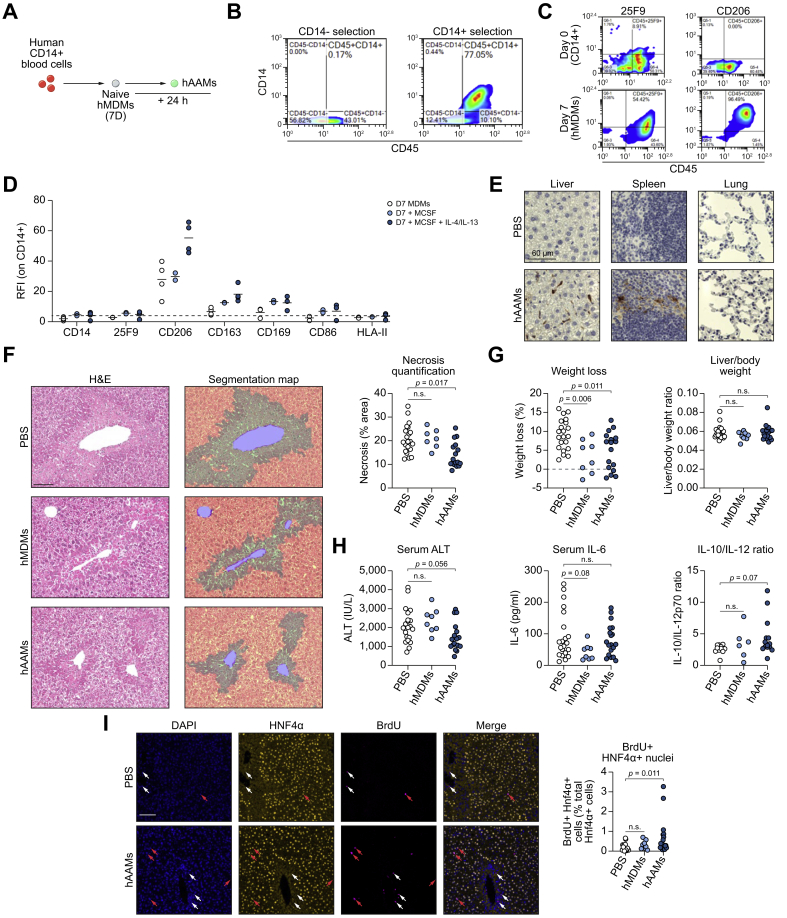
Injection of hAAMs reduces necrosis in APAP-ALI immunocompetent mice.(A) hMDMs were differentiated from CD14+ cells isolated from healthy volunteer buffy coats, before incubation with hCSF-1 for 7 days. hAAMs were generated by stimulating hMDMs overnight with hCSF1, hIL-4, and hIL-13. (B) Representative flow cytometry plots demonstrating CD14-enrichment using CliniMACS® beads (C) Representative flow cytometry plots showing macrophage maturity markers (25F9, left panels; CD206, right panels) in CD14+ cells (top) and hMDMs (bottom) (D) Flow cytometry quantification of hMDMs (white), hMDMs stimulated with CSF-1 alone (light blue), and fully-stimulated hAAMs (dark blue), spots represent individual donors. (E) Panels show representative anti-FITC immunohistochemical stains in liver (left), spleen (centre), and lung (right) from APAP-ALI mice treated with PBS (top row) or hAAMs (bottom row). (F) Representative histological staining (left) and necrosis segmentation map (centre) in APAP-ALI mice with indicated treatments. Necrosis quantification in right panel (n ≥7 mice per group). (G) Percentage weight loss (left panel) and liver/body weight ratio (right panel) of APAP-ALI mice with indicated treatments (n ≥8 per group) (H). Serum injury/inflammatory markers in APAP-ALI mice receiving indicated treatments (n ≥6 per group; serum ALT activity, left panel; serum IL-6, centre panel; serum IL-10/-12p70 ratio, right panel, some sera has undetectable IL-12p70 levels). (I) Representative dual immunofluorescence images of HNF4α (yellow) and BrdU (magenta) against DAPI (counterstain, blue) in liver tissue from APAP-ALI mice treated with PBS (top row) or hAAMs (bottom row). White arrowheads indicate BrdU-positive cells, red arrowheads indicate dual-positive BrdU-positive HNF4α-positive cells (quantification right panel; n≥ 8). Scale bars 100 μm, unless otherwise indicated. p values indicated in panels, n.s. not significant. One-way ANOVA test in F, G (weight loss %), H (ALT), or Kruskal-Wallis test in G (liver/body ratio), H (IL-6, IL-10/-12 ratio), and I. ALI, acute liver injury; APAP, acetaminophen; APAP-ALI, APAP-induced ALI; hAAMs, alternatively activated macrophages; hMDMs, human monocyte-derived macrophages.